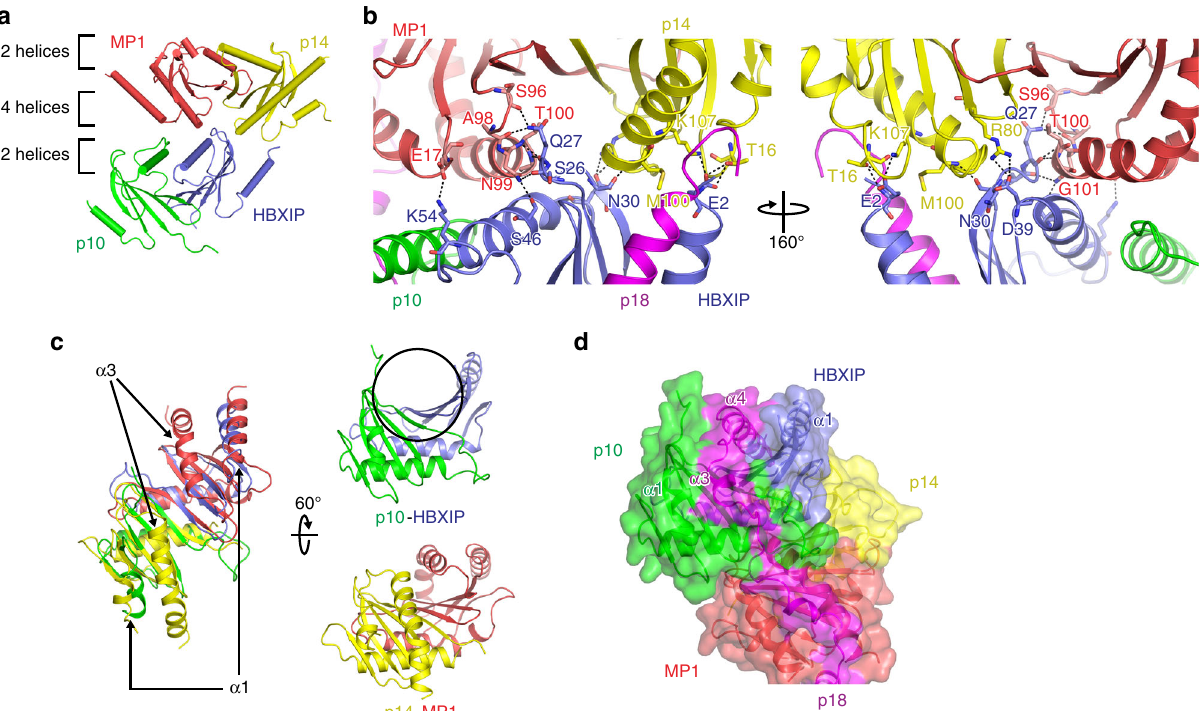
Fig. 2 Assembly of p14-MP1 and p10-HBXIP heterodimers. a The orientations of roadblock heterodimers upon formation of the heterotetramer in the structure of Ragulator. The β 1 – β 2 loop near the two helices docks into the groove formed by the α 3 helix on the side of four helices. b Ribbon model representation of interactions between p14-MP1 and p10-HBXIP roadblock dimers (left panel). The structure is viewed from different angles rotated at 160° along the vertical axis (right panel). Hydrogen bonds are shown as black dashed lines. c Ribbon model representation of the p10-HBXIP dimer superimposed on the p14-MP1 dimer (left panel). The structures of each dimer are viewed from different angles rotated at 60° along the horizontal axis (right panel). The groove formed in the p10-HBXIP dimer is shown as circled. d Ribbon model representation of p18 superimposed on p14, MP1, p10, and HBXIP. Molecular surface models are also